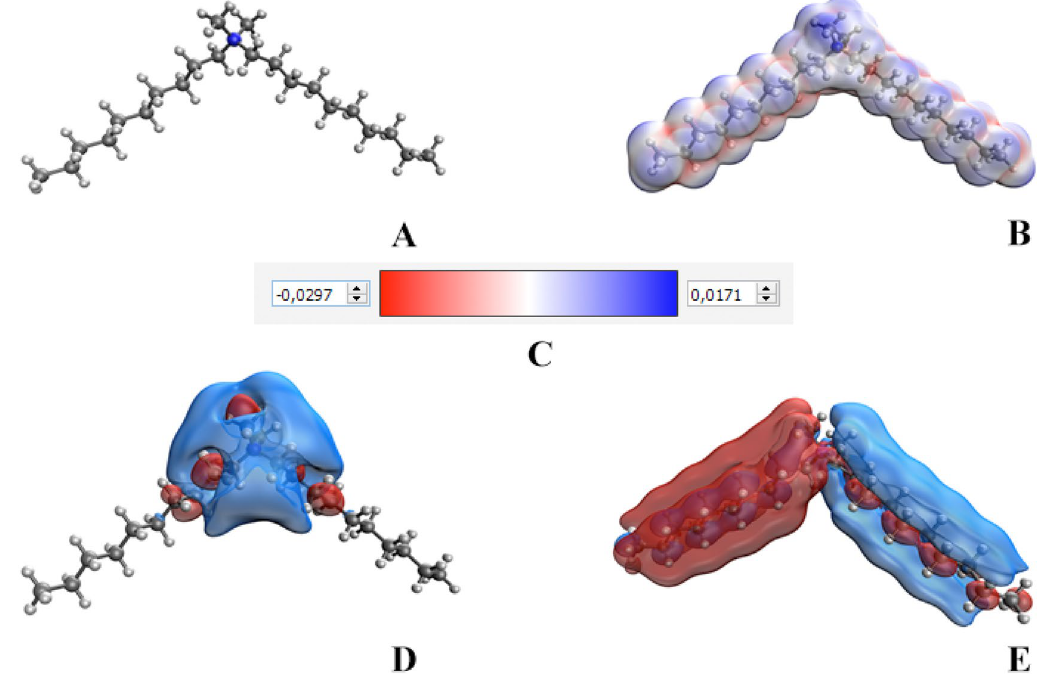
Figure 5. Results of quantum chemical modeling of the DDAC: molecular model ( A ), electron density distribution ( B ), electron density distribution gradient ( C ), highest occupied molecular orbital HOMO ( D ), lowest unoccupied molecular orbital LUMO ( E ).